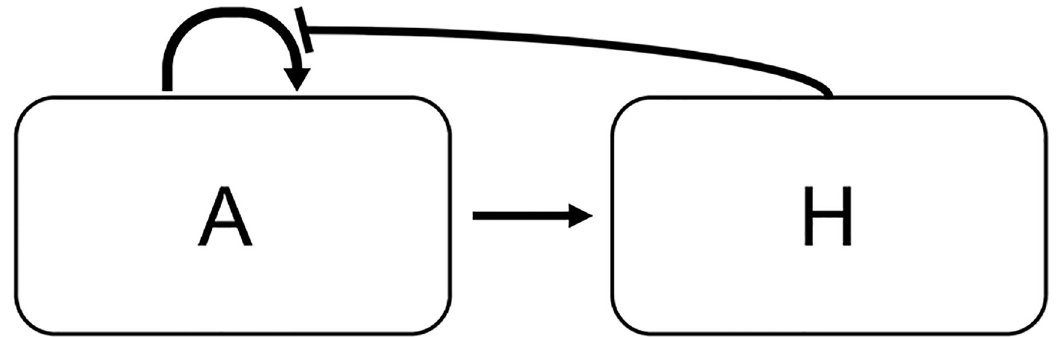
Fig 2. Morphogen interaction diagram. The activator (A) self-activates and activates the inhibitor. The inhibitor (H) inhibits the activator.